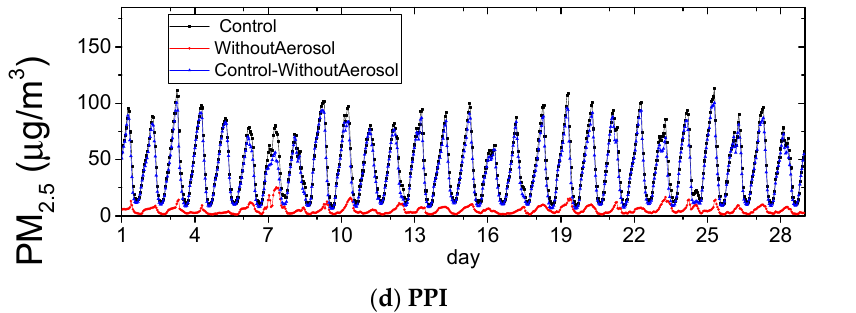
Figure 7. Comparison between simulation case base (control), sensibility simulation (WithoutAerosol),